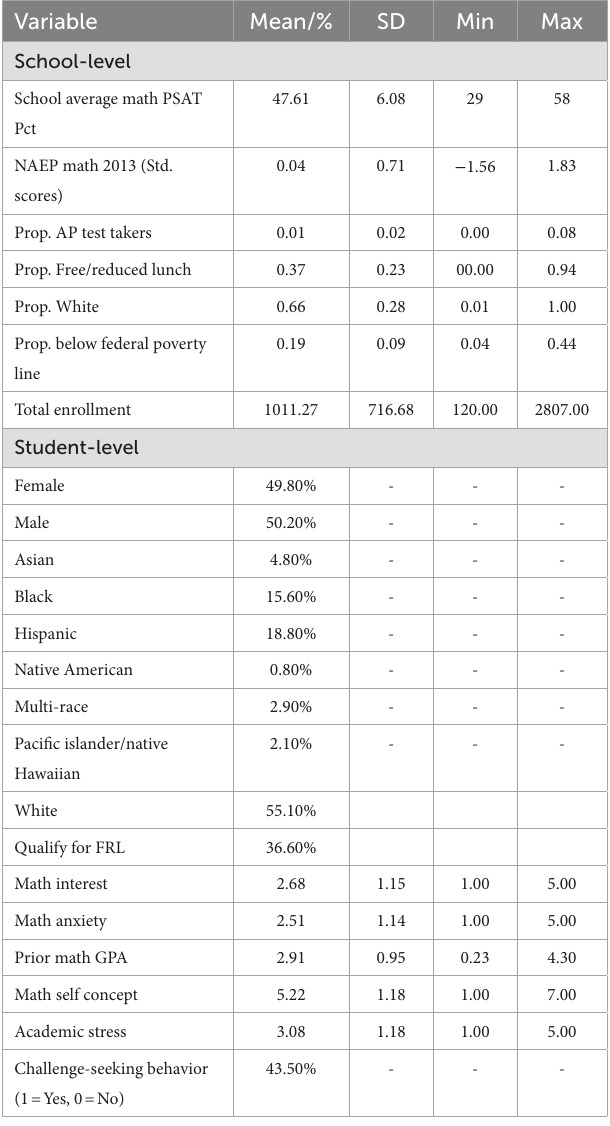
TABLE 1 Student and school-level descriptive statistics for analytic